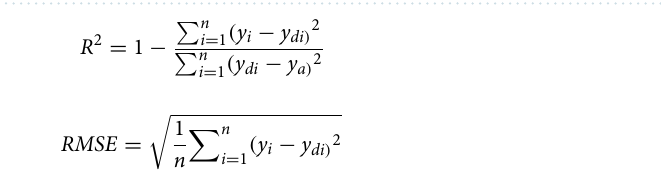
Figure 1. Multilayer feed forward neural network for eight input variables, 15, 10 and 3 neurons in the first, second and last hidden layers respectively and one output